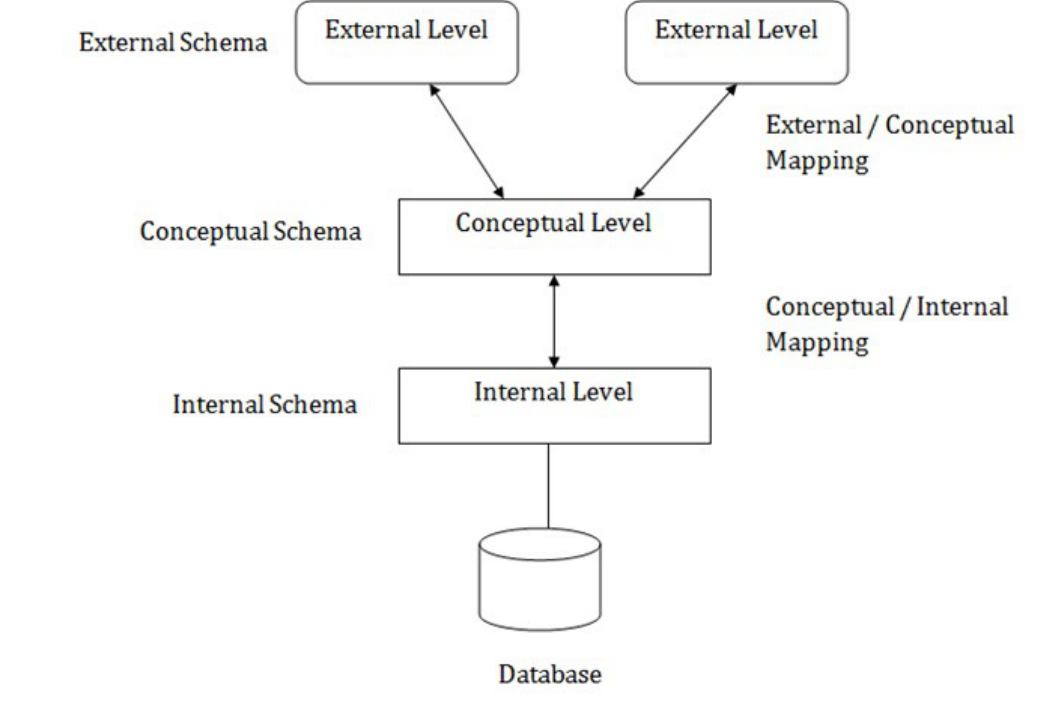
Figure 8. Schema mapping